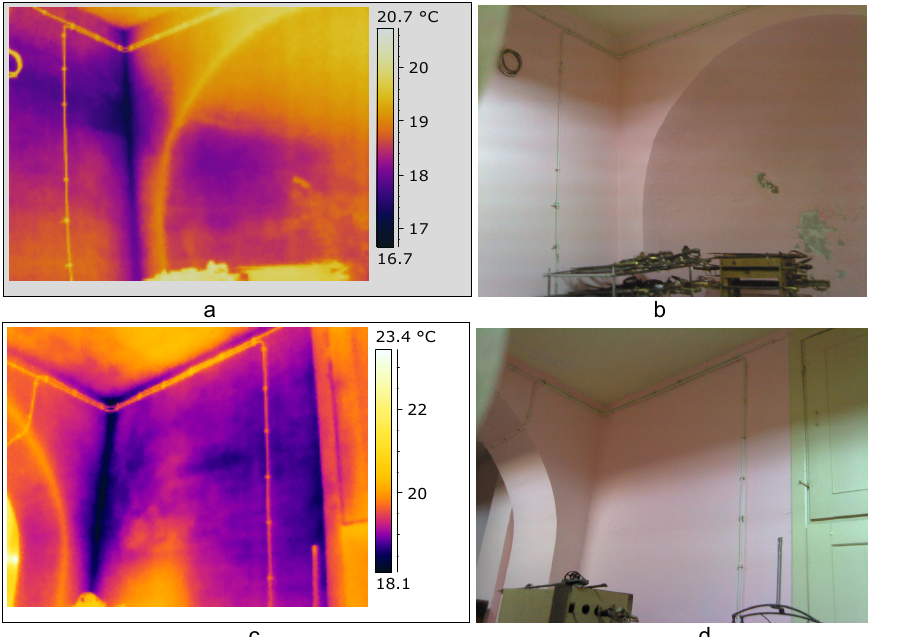
Figure 4 – Thermograms and the photos of the weapons depot with visible moisture Slika 4 – Termogrami I fotogarfije depoa naoružanja sa vidljivom